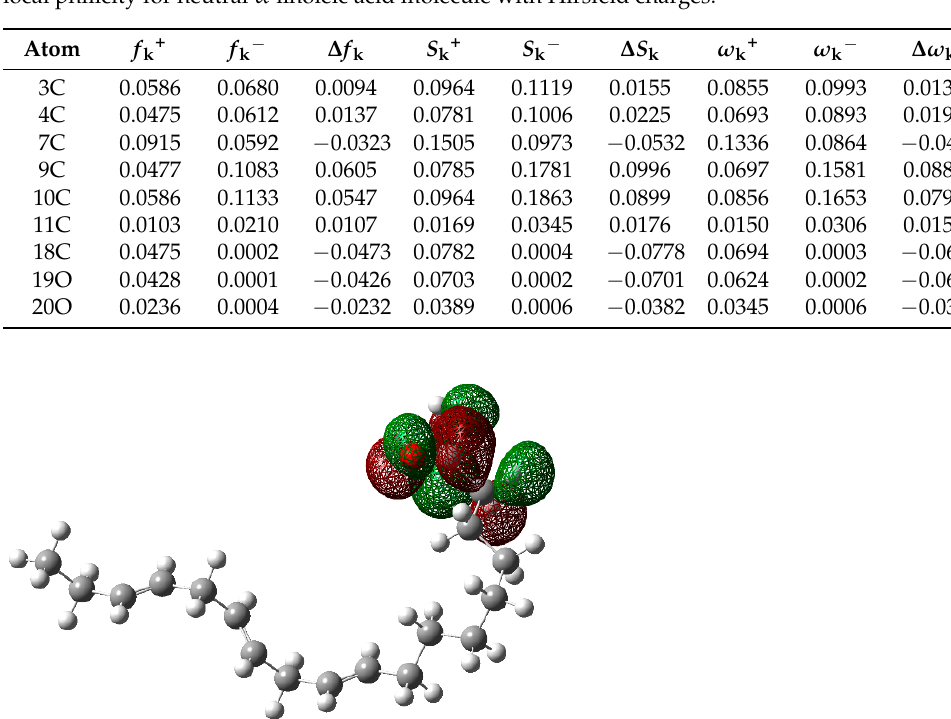
Figure 9. The highest occupied molecular orbital (HOMO) of α -linoleic acid in the aqueous phase. Figure 8. Optimized structure of the α -linoleic acid in the aqueous phase. Table 5. Fukui functions, local softness, philicity, dual Fukui functions, dual local softness and dual local philicity for neutral α -linoleic acid molecule with Hirsfeld charges.